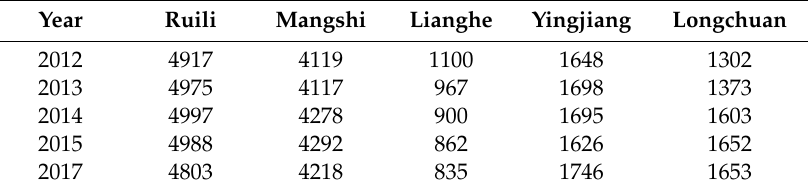
Table 4. Total urban center DN values for the DH Prefecture from 2012 to 2017.